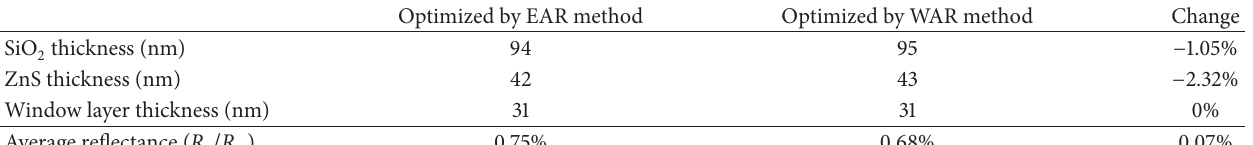
/ZnS ARC for dual junction SC optimized by different methods. 2